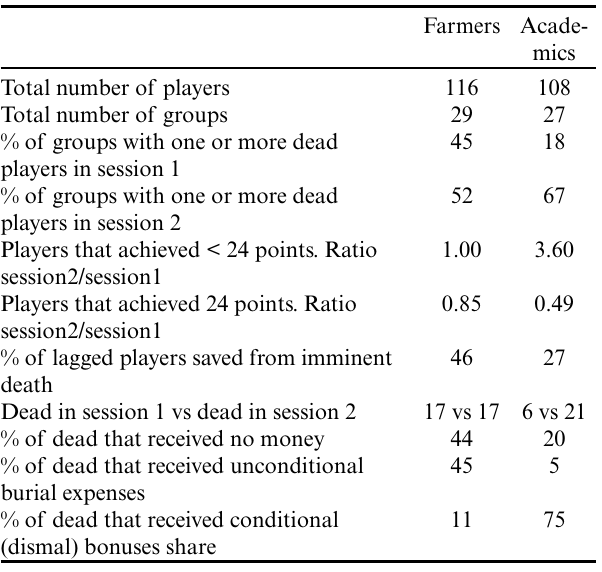
Table 1 . How players dealt with approaching death. A comparison across sessions and